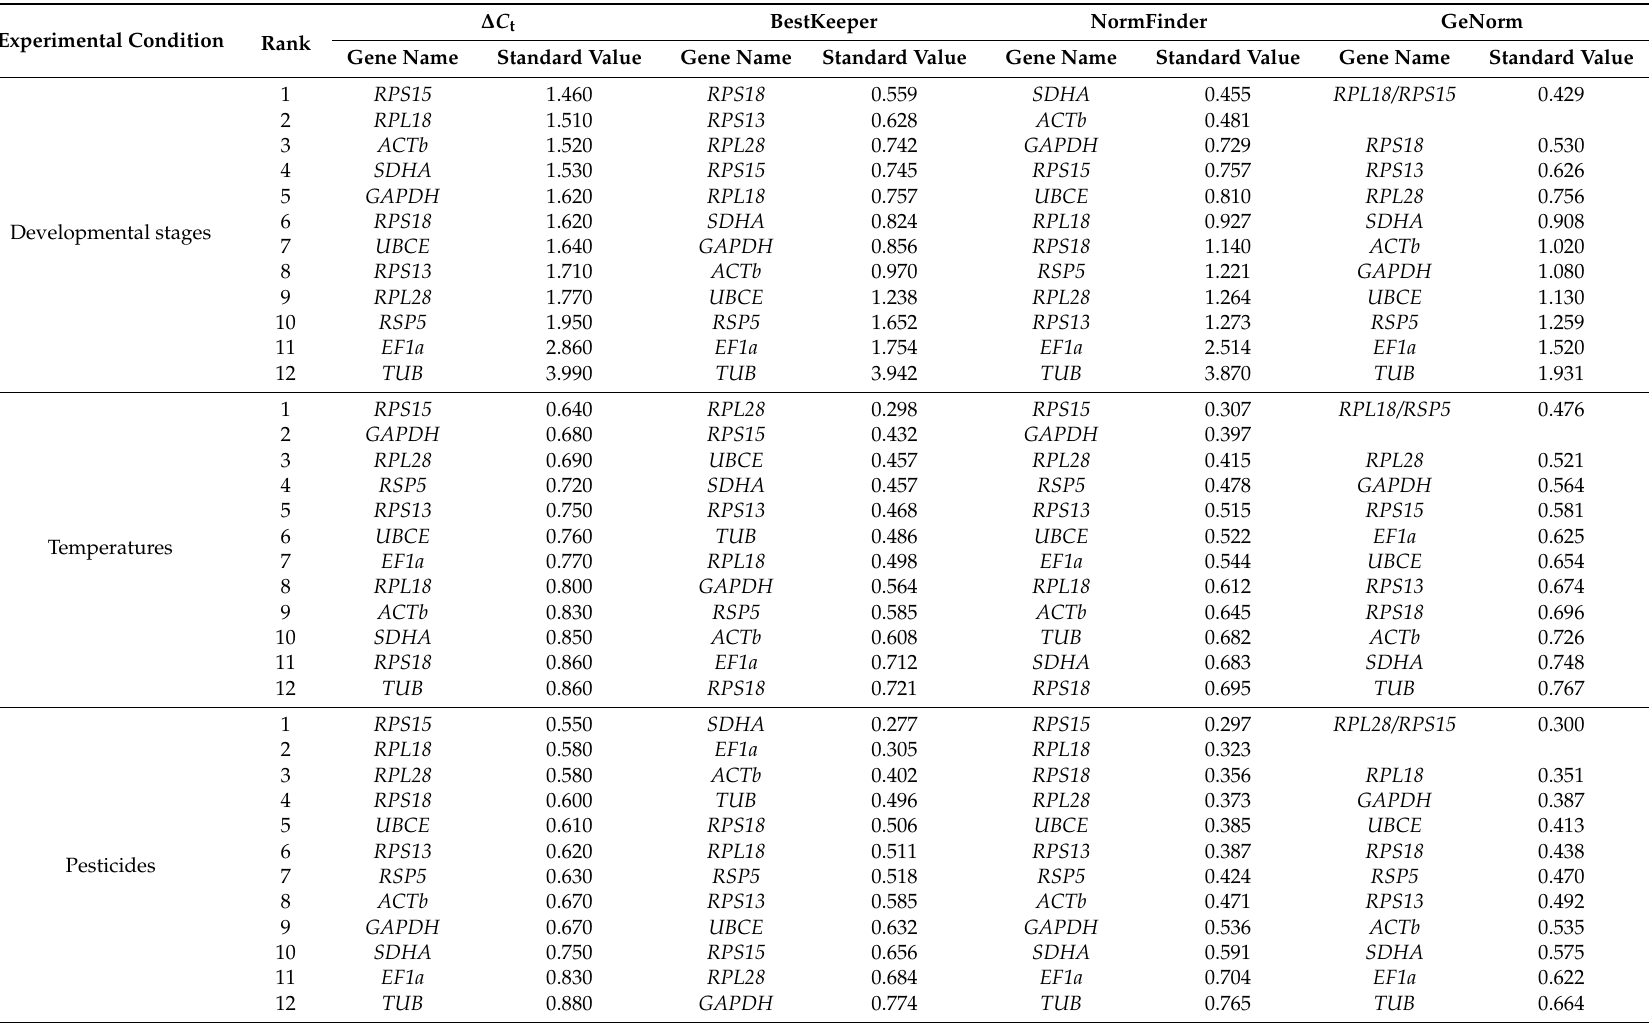
Table 2. Expression stability of the 12 candidate housekeeping genes in B. odoriphaga under various experimental